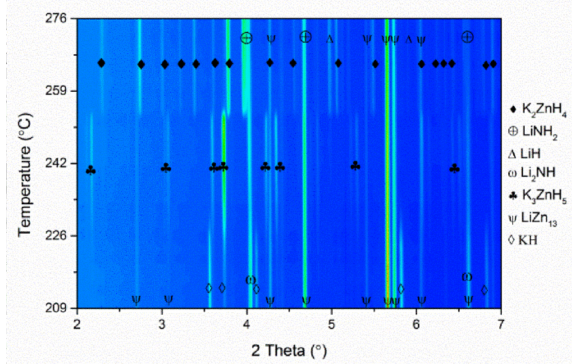
Figure 8. Re-hydrogenation contour plot of the K 2 [Zn(NH 2 ) 4 ] + 8LiH composite at the temperature range between 209 and 276 ◦ C (heating rate of 2 ◦ C/min, λ = 0.20775 Å)